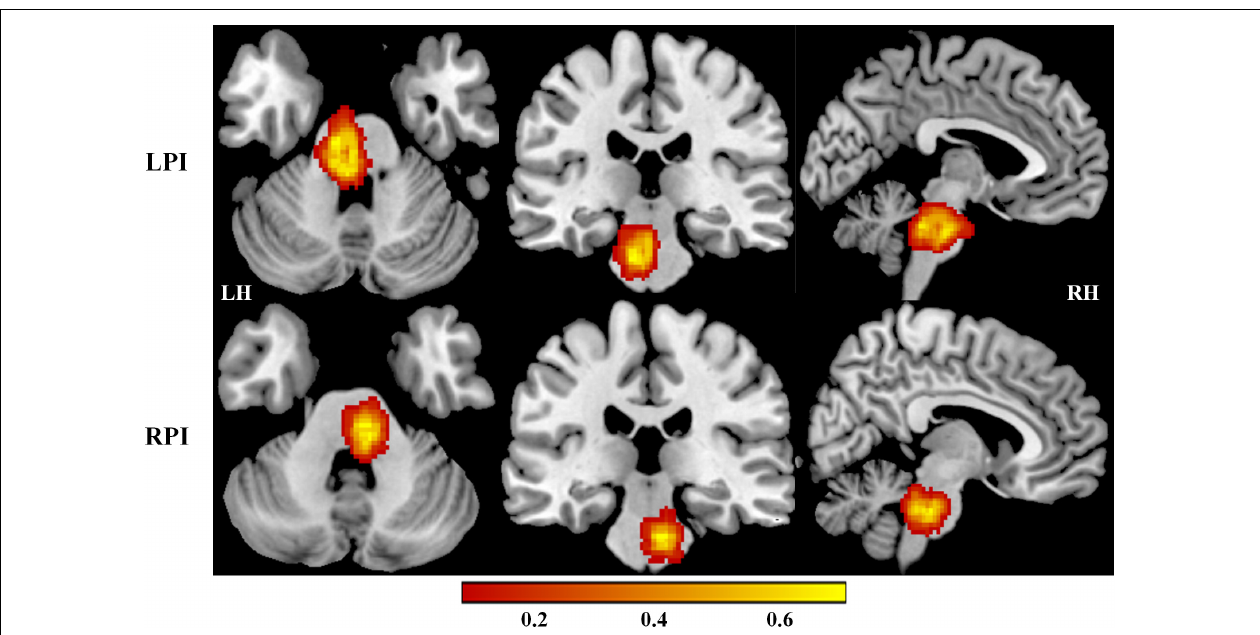
FIGURE 1 | Lesion distribution maps in the LPI and RPI groups. The color bar represents the lesion probability. LH, left hemisphere; RH, right hemisphere; LPI, left pontine infarction; RPI, right pontine infarction.